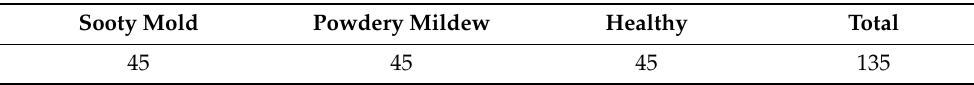
Figure 2. Data augmentation steps. Table 1. Distribution of the